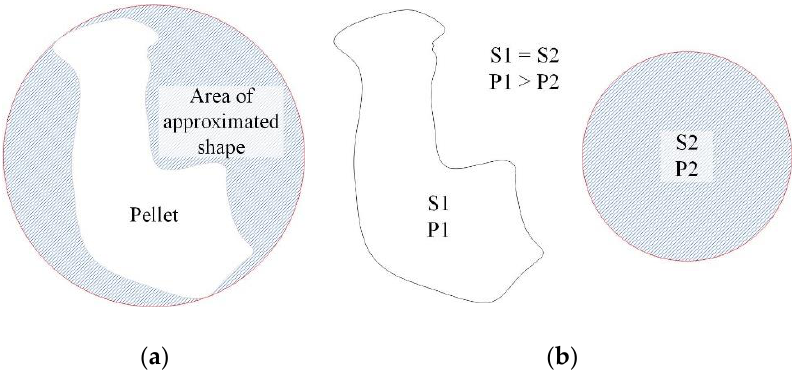
( f ) Figure 1. Models of pellet approximation: ( a , b )—pellet is approximated using a circle drawn around it and a circle drawn inside of it; ( c , d )—pellet is approximated using best fit rectangle drawn around it and rectangle drawn inside of it; ( e , f )—pellet is approximated using a ellipse drawn around it and a ellipse drawn inside of it. Such forms of approximation are characterized by limitedness, as in the case of an irregular